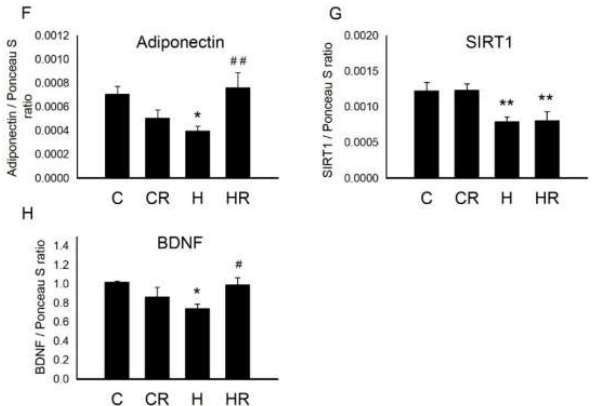
Figure 2. Targeted protein levels in rat fetal brain. The levels of fetal brain targeted proteins were detected via Western blotting and normalized using Ponceau S staining. ( A ) Representative band densities are shown. Relative abundance of ( B ) pPPARγ/PPARγ, ( C ) pIRS1 (s616)/IRS1, ( D ) pIRS2 (s731)/IRS2, ( E ) pAKT/AKT, ( F ) adiponectin, ( G ) SIRT1, and ( H ) BDNF were quantified. One-way ANOVA followed by Fisher’s LSD post hoc was used to assess the significant differences among groups and multiple comparisons. pPPARγ/PPARγ: (F (3,20) = 3.470, p < 0.05). pIRS2 (s731)/IRS2: (F (3,24) = 3.647, p < 0.05). pAKT/AKT: (F (3,20) = 4.261, p < 0.05). Adiponectin: (F (3,20) = 4.226, p < 0.05).